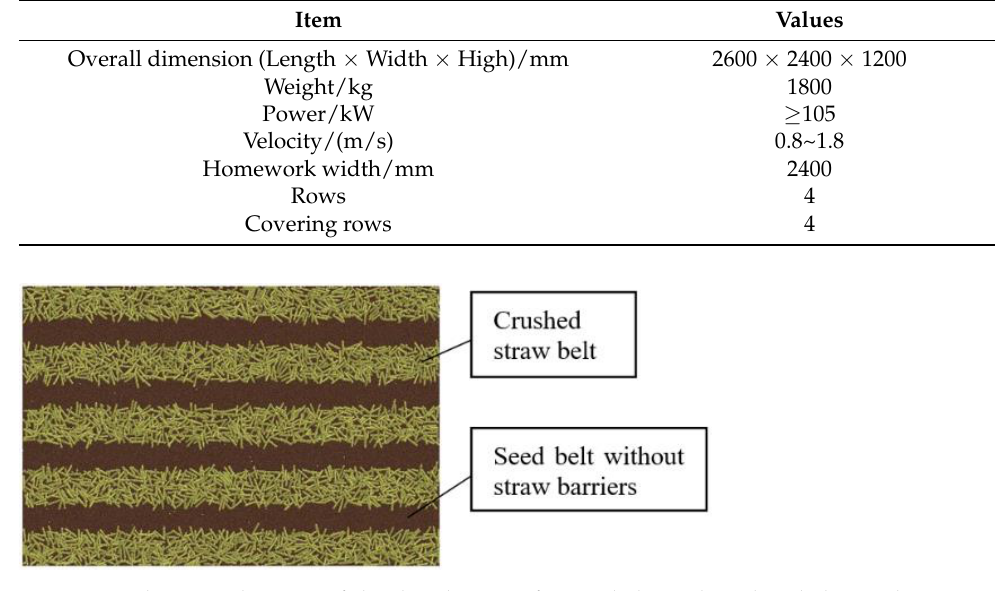
Figure 4. Schematic diagram of the distribution of straw belts and seeding belts on the ground after sowing. Table 1. Main technical parameters.